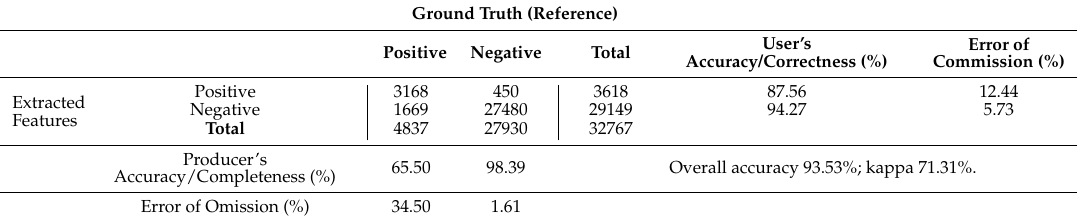
Table 4. Confusion (error) matrix for assessing the quality of extracted landslide scarps based on the topographic surface roughness